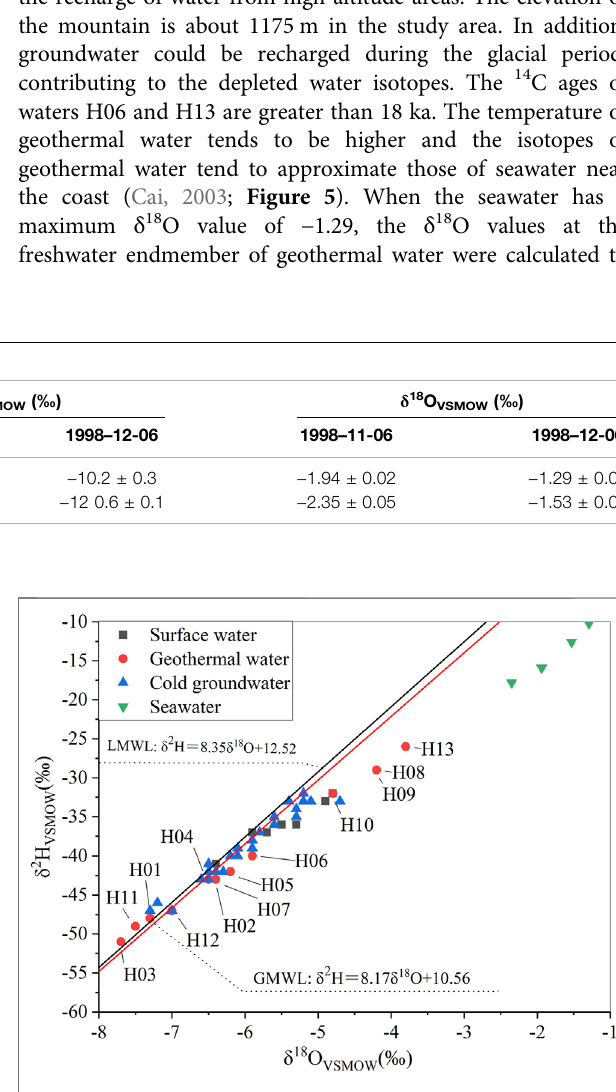
FIGURE 5 | Distribution of stable hydrogen and oxygen isotopes in geothermal water in